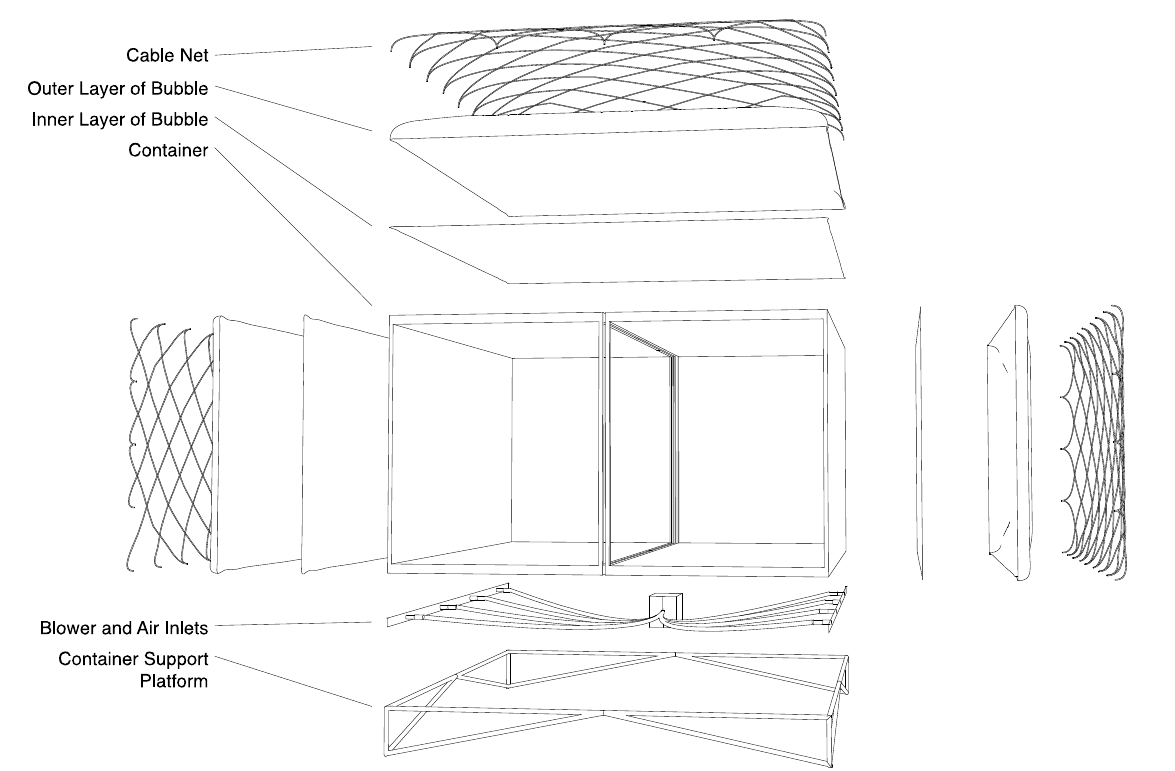
Figure 2. Exploded view of the inflated skin.